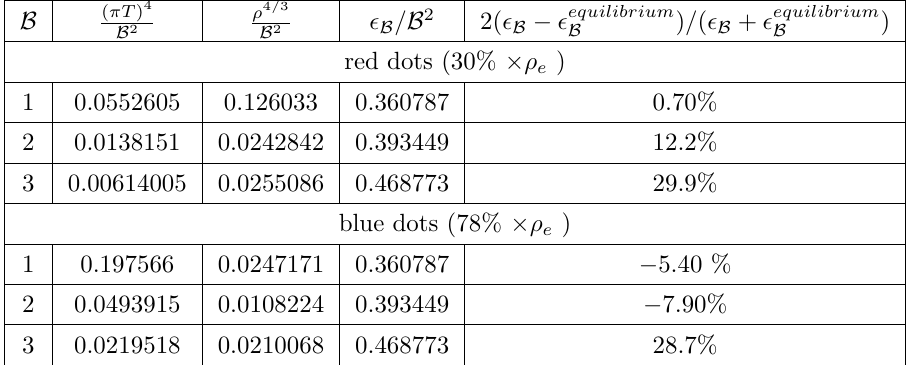
, = 1 , 1 . 5 , 2 , 2 . 5 , 3) dots e B